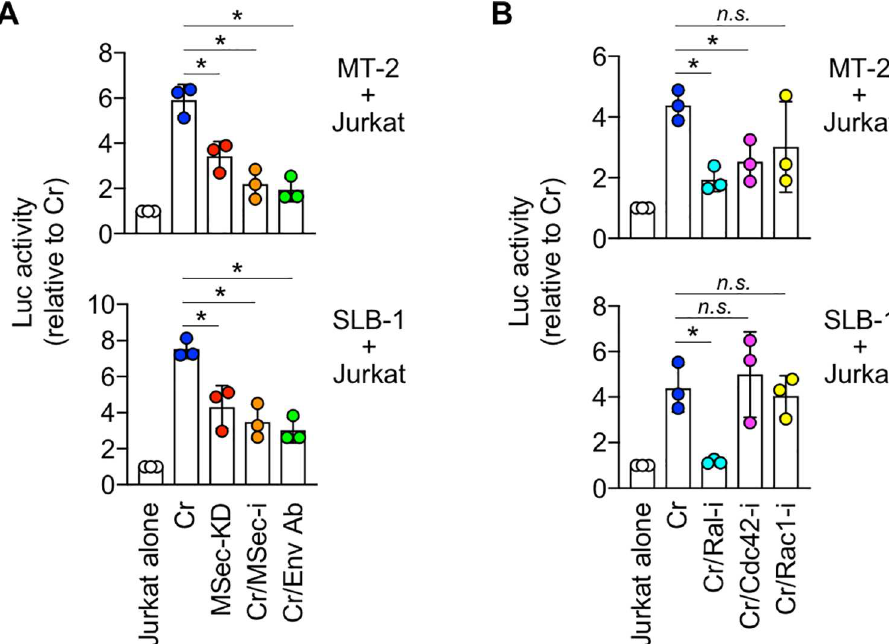
Fig 4. Effect of M-Sec knockdown/inhibition on viral infection in co-culture using cell lines. ( A ) Reporter Jurkat cells were cultured alone (Jurkat alone), or co-cultured with the control (Cr) or M-Sec knockdown (MSec-KD) MT-2- or SLB-1 cells for 16 h. In assays in which the effect of M-Sec inhibitor (MSec-i) was tested, control MT-2- or SLB-1 cells were pre-treated with MSec-i for 48 h and used for the co-culture (Cr/MSec-i). The anti-gp46 Env neutralizing antibody was included as a reference (Cr/Env Ab). The luciferase activities are shown by setting the value of Jurkat alone as 1 (n = 3). � p < 0.05. ( B ) The control MT-2- or SLB-1 cells were pre-cultured in the absence (Cr) or presence of Ral inhibitor (Cr/Ral-i), Cdc42 inhibitor (Cr/Cdc42-i), or Rac1 inhibitor (Cr/Rac1-i) for 48 h, and used for the co- culture with Jurkat cells. The luciferase activities are shown by setting the value of Jurkat alone as 1 (n = 3). � p < 0.05.